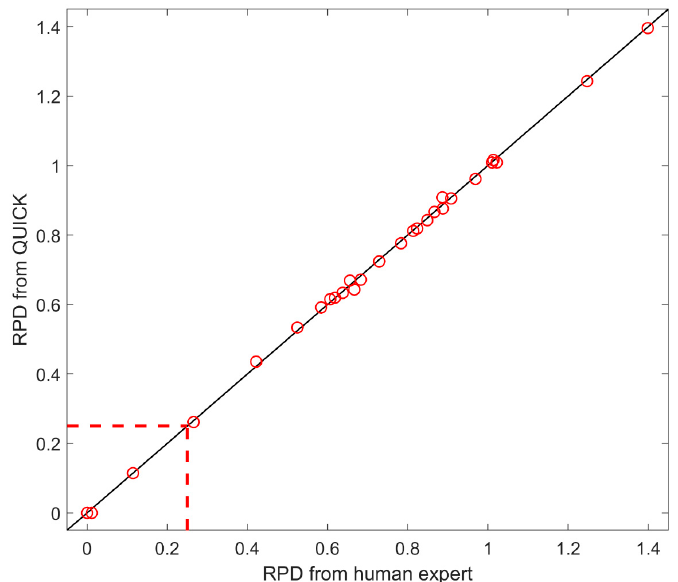
Figure 8. Comparison of relative percent difference (RPD) between human expert ( x axis) and QUICK ( y axis) for different congeners. Each circle represents a congener. If a circle is located on the solid diagonal line, the congener has the same RPD from QUICK and the human expert. The dashed lines represent the threshold at 0.25 and divide the plot into two regions. The bottom left region has 17 congeners that meet the criterion of RPD < 0.5, while the upper right region contains 25 congners that do not meet the criterion.